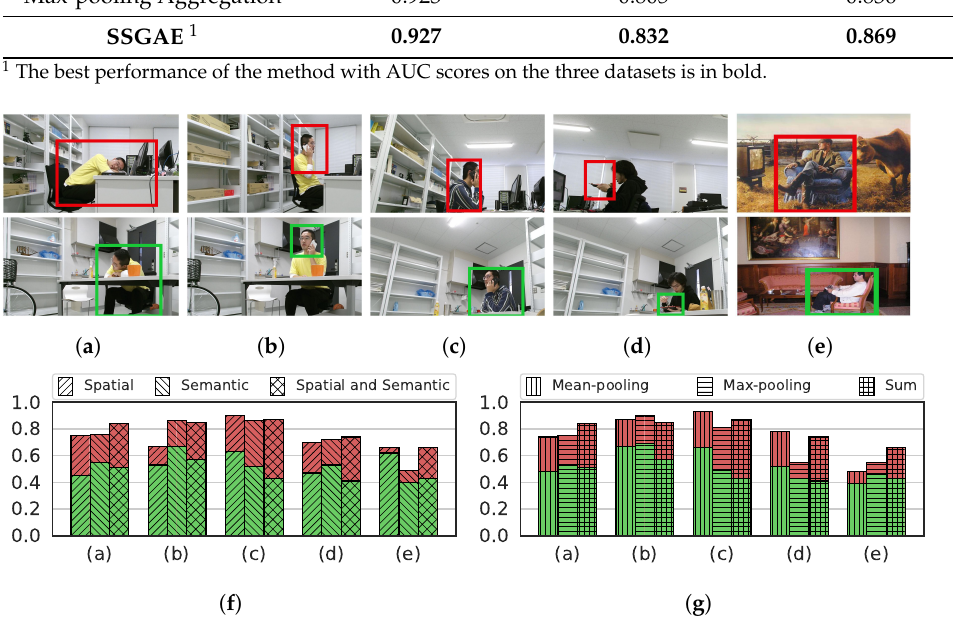
Figure 10. Examples of abnormal and normal regions with anomaly scores. ( a – d ) Examples of abnormal regions with red boxes and normal regions with green boxes in a laboratory environment. ( e ) Examples of an abnormal region with a red box outside a room and a normal region with a green box inside a room. ( f ) Anomaly scores of the abnormal regions with red color and normal regions with green color in ( a – e ) by the different kinds of graphs. ( g ) Anomaly scores of the abnormal regions with red color and normal regions with green color in ( a – e ) by the different aggregation